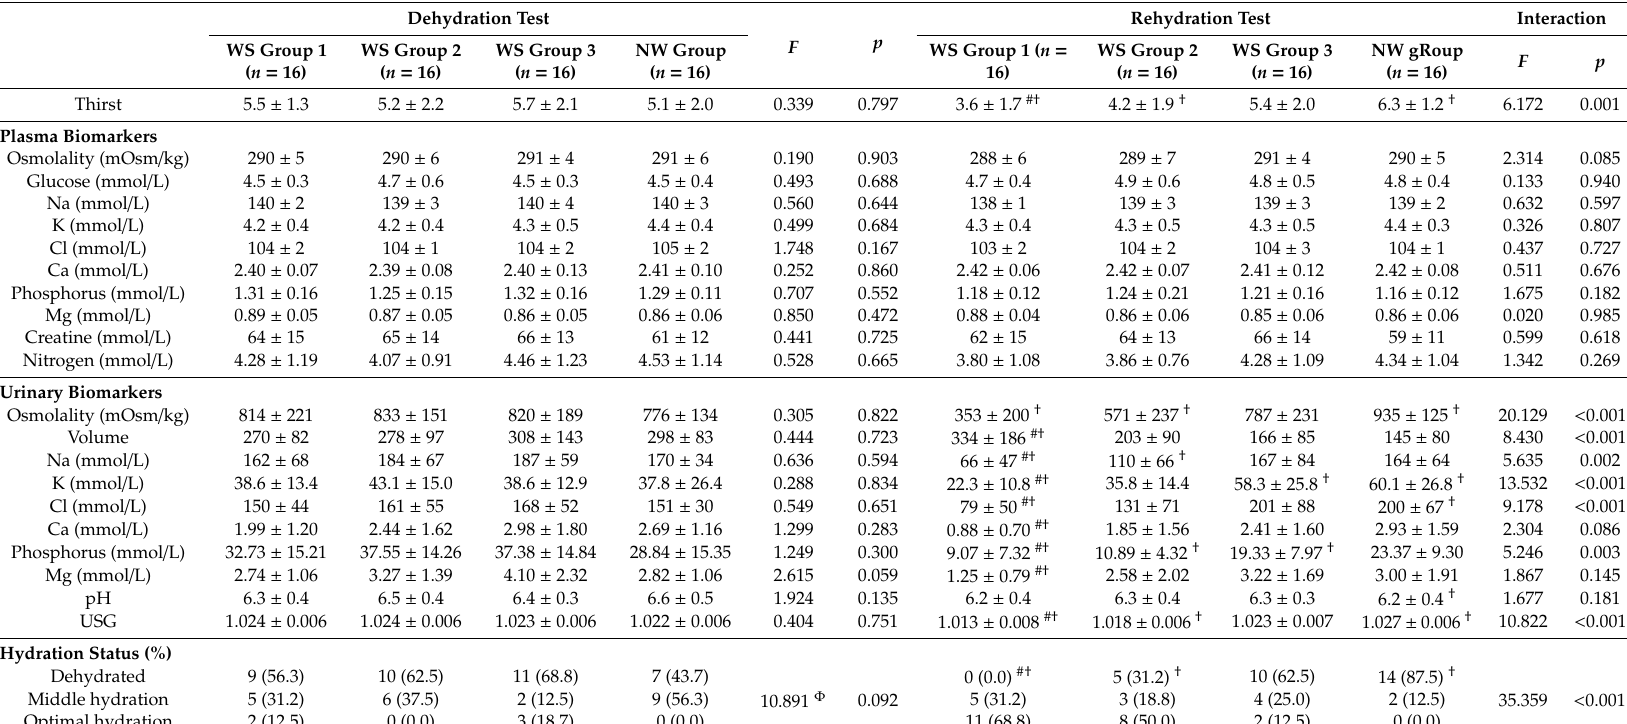
Table 2. Thirst, urine, and plasma biomarkers of